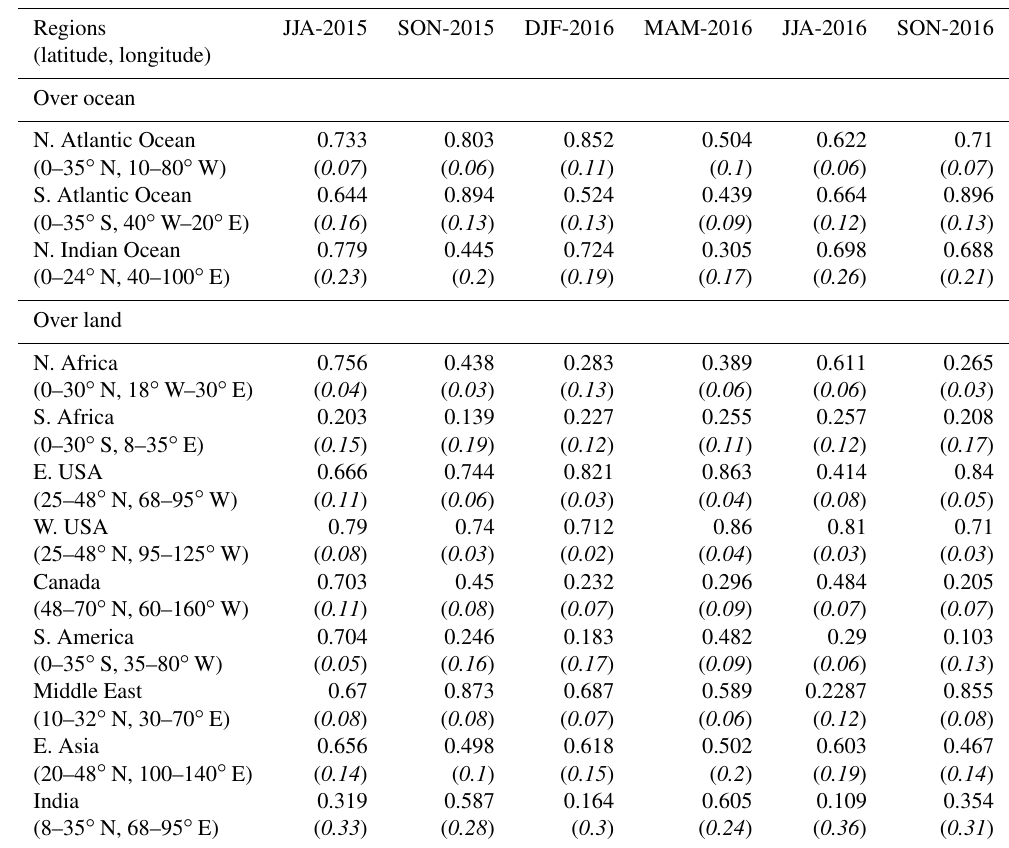
Table 1. Correlation coefficients and RMSE (in italics) of total AOT at 550nm in different seasons between NGACv2 and MODIS over selected regions of the globe. Daily AOT from model and satellite data are considered for these